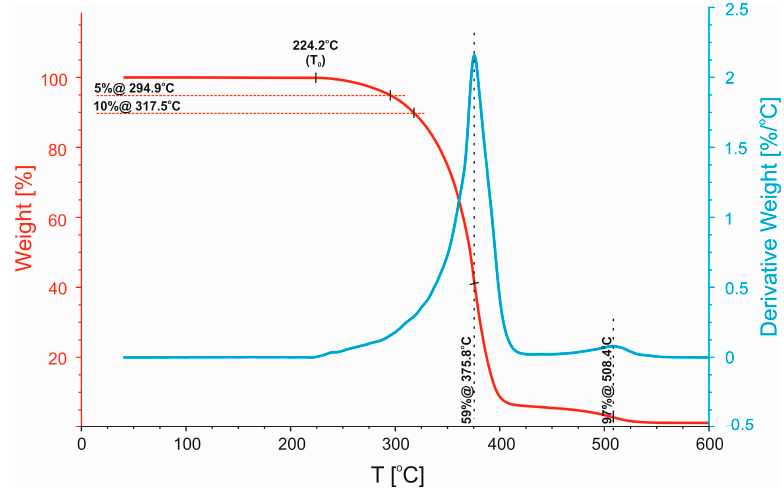
Figure 9. Non-isothermal analysis of TG and DTG thermograms of 50/50 PP/PBT blend containing SEBS copolymer. Table 4. Thermal decomposition temperatures of 50/50 PP/PBT blends. Polymer Blend